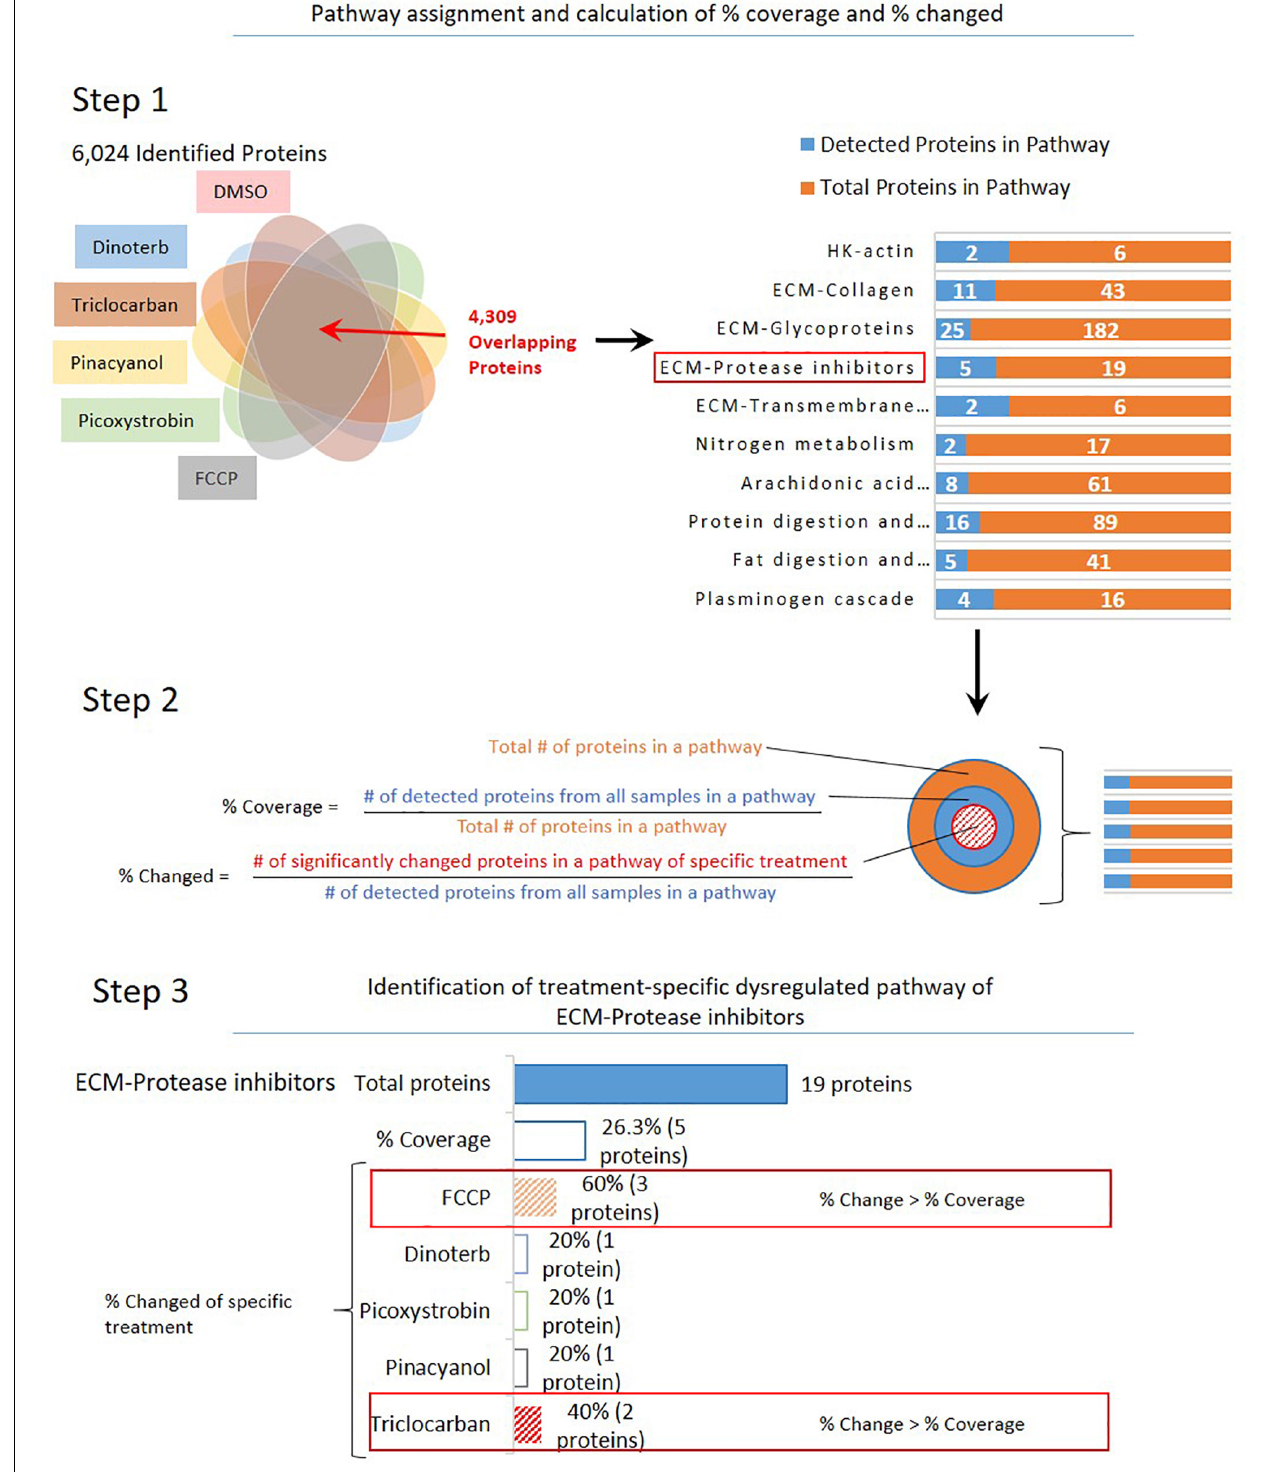
FIGURE 3 | Overview of selection for dysregulated pathways in treatment-specific analysis. Step 1: A total of 4,309 overlapped proteins in all six groups of samples were assigned to 186 pathways based on annotation. Step 2: Calculation of percent of coverage and percent of dysregulation. Step 3: An example (ECM-protease inhibitors) to show selection criteria of specific treatment: Percent of dysregulation in a single treatment group is greater than percent coverage of all samples.